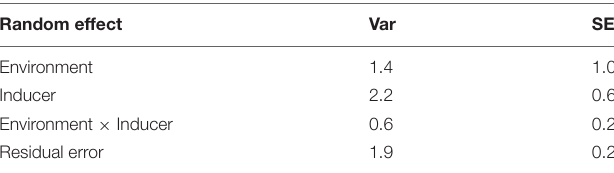
TABLE 3 | Estimates of variance components (Var) and their standard errors (SE) for HIR of thirty six candidate inducers evaluated across six environments. Random effect Var